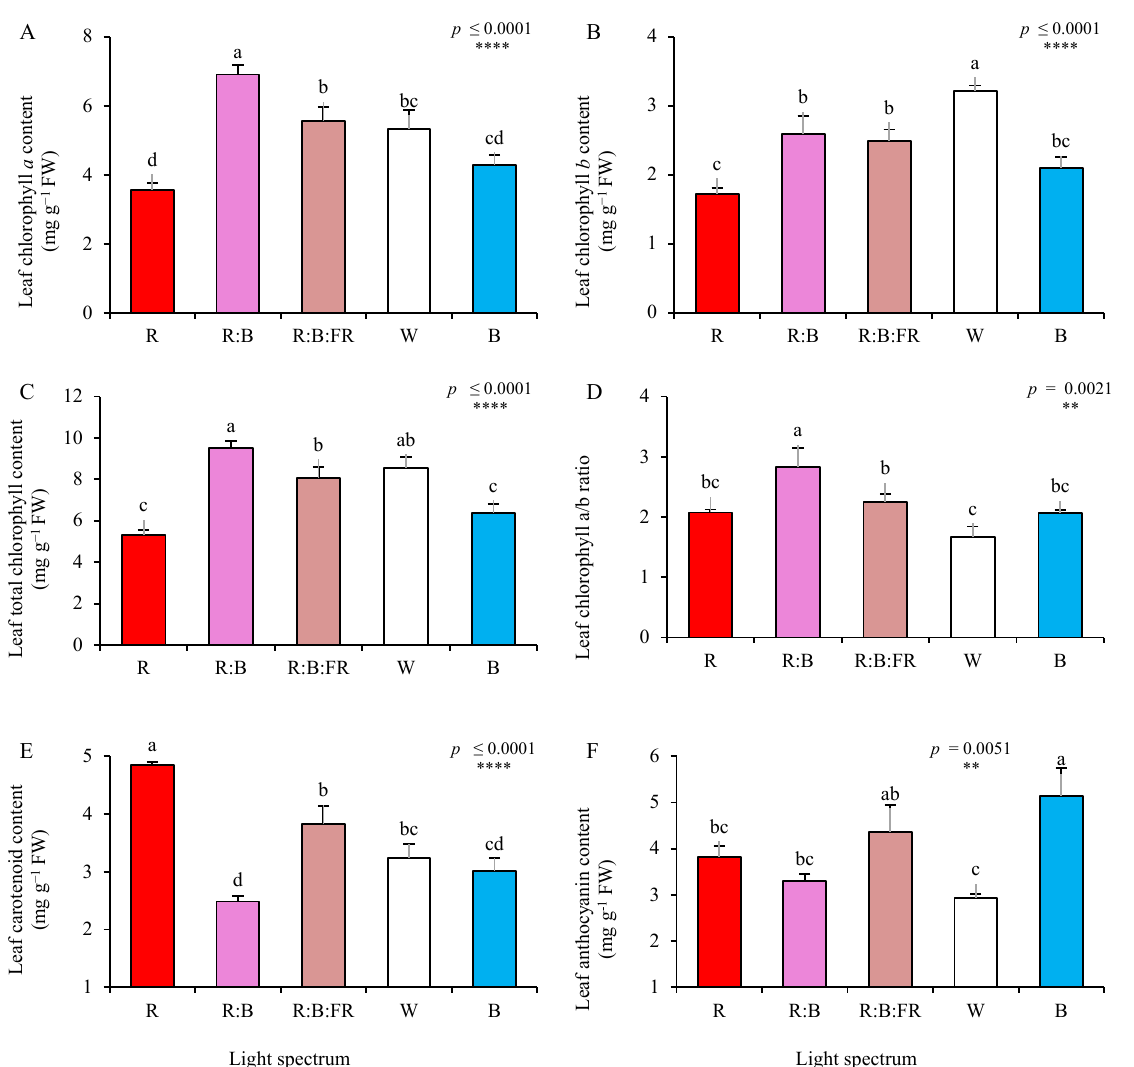
Figure 3. Leaf chlorophyll a and b ( A , B ), total chlorophyll ( C ), chlorophyll a / b ratio ( D ), total carotenoids ( E ), and total anthocyanin content ( F ) of Chrysanthemum cuttings exposed for 30 days to different light quality regimes (red (R), red and blue (R:B), red, blue and far-red (R:B:FR), white (W) and blue (B); see the spectrum in Figure 9). During the experiment, the photosynthetic photon flux density was set to 150 ± 5 µ mol m − 2 s − 1 . Six replicates per treatment were assessed. Columns with the same letters are not significantly different at p ≤ 0.05, according to Duncan’s multiple range tests. Bars represent SEM.